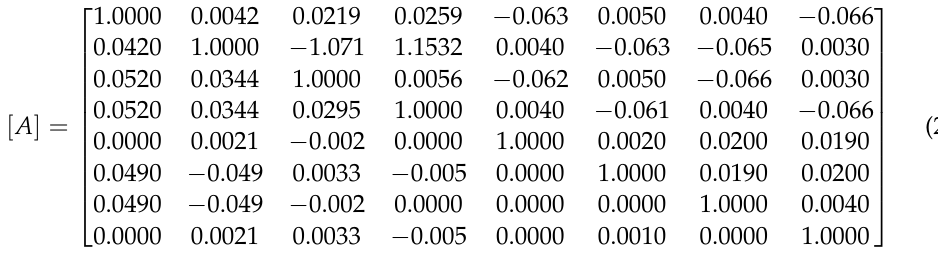
Figure 6. Rotor finite element model. ( a ) First-stage disc finite element model. ( b ) Second-stage disc finite element model.